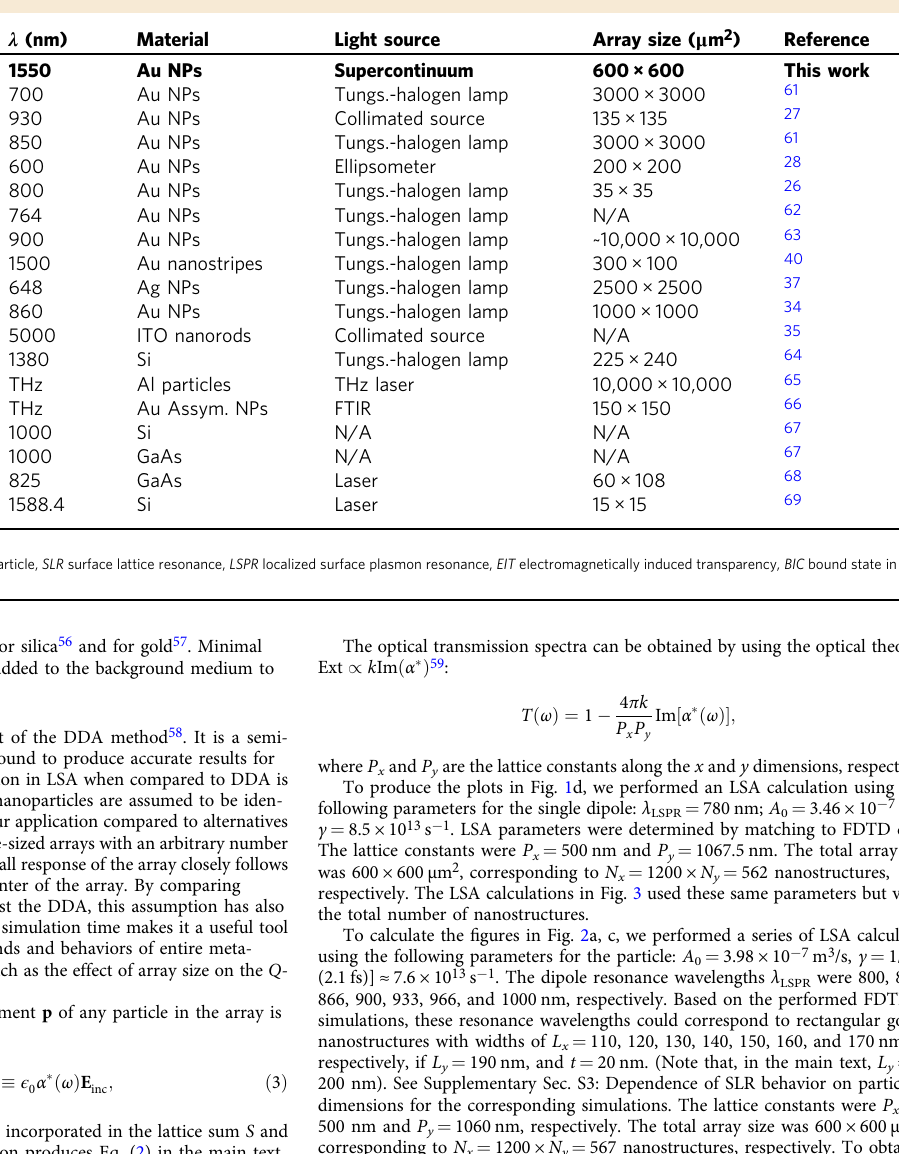
Table 1 Summary of experimentally obtained Q -factors in